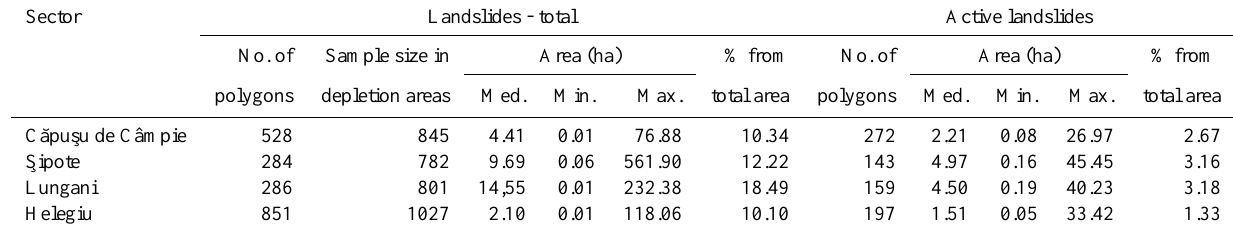
Table 2. Landslide types for the study sectors. Sector Shallow landslides Deep seated landslides Complex landslides No. of Mean Total No. of Mean polygons area (ha) ¸Sipote 215